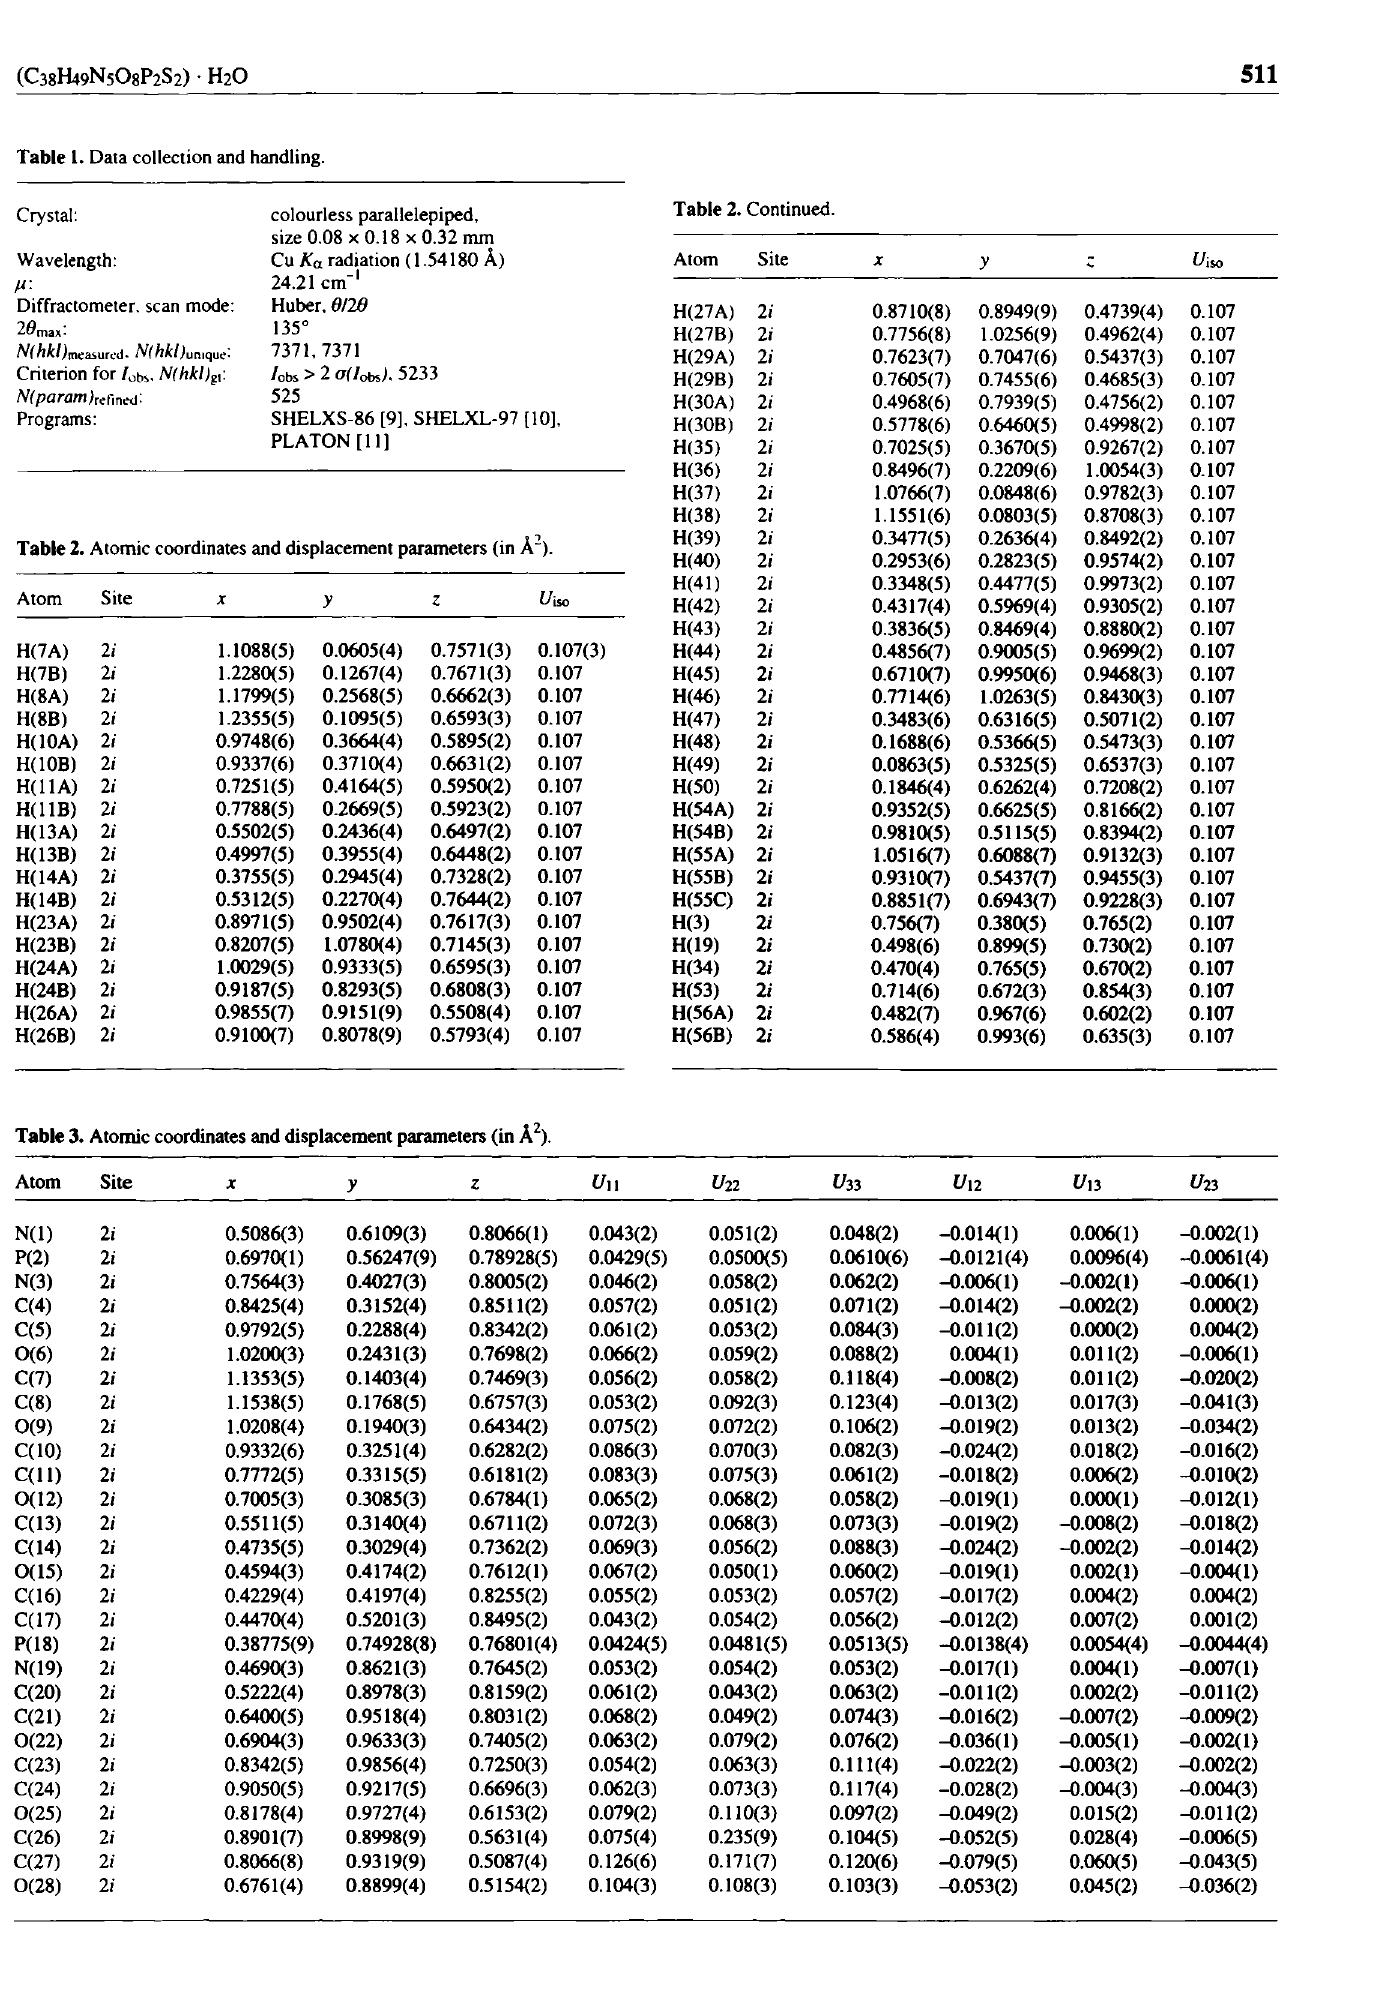
Table 2. Atomic coordinates and displacement parameters (in λ 1 ).